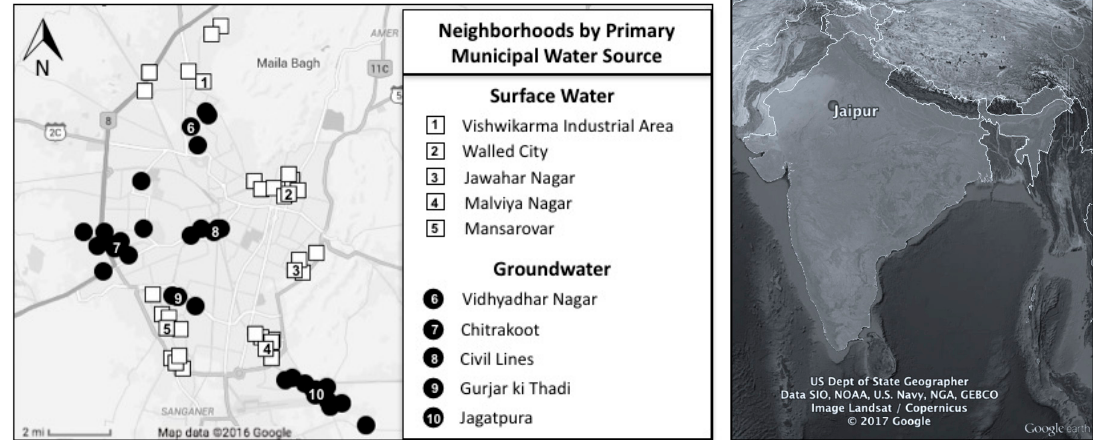
Figure 1. Survey locations in Jaipur City and Jaipur City’s location in India.